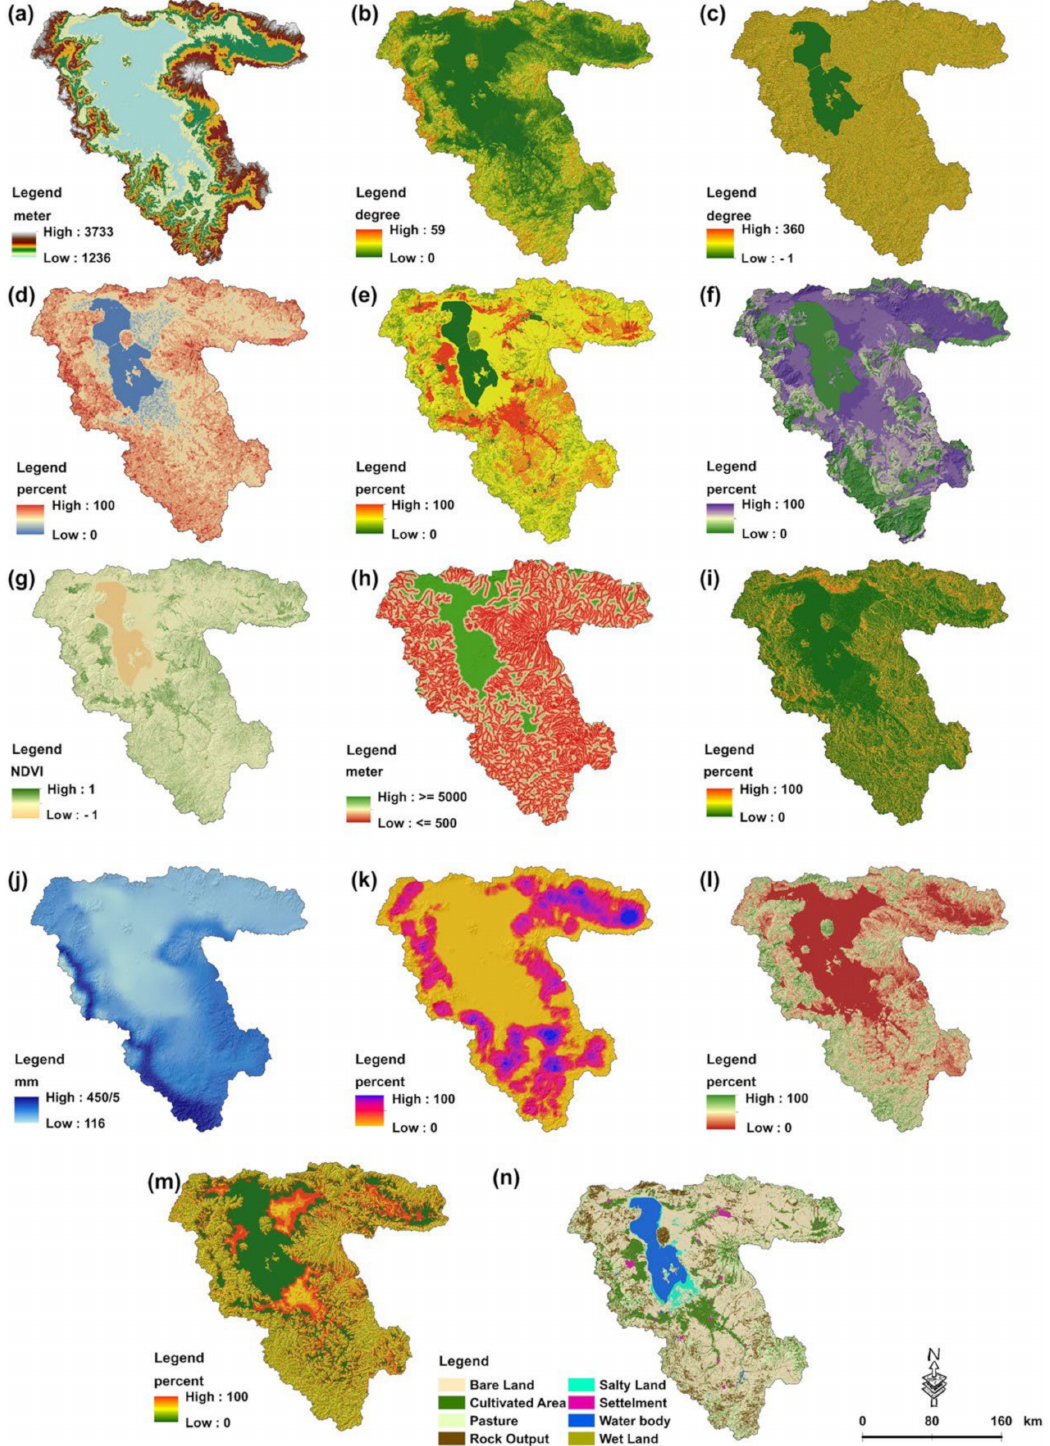
Figure 3. Selected criteria including: ( a ) elevation; ( b ) slope degree; ( c ) slope aspect; ( d ) curvature; ( e ) soil depth; ( f ) soil texture; ( g ) vegetation density; ( h ) distance from river; ( i ) Stream Power Index; ( j ) annual precipitation; ( k ) drainage density; ( l ) slope length; ( m ) topographic wetness index; and ( n )